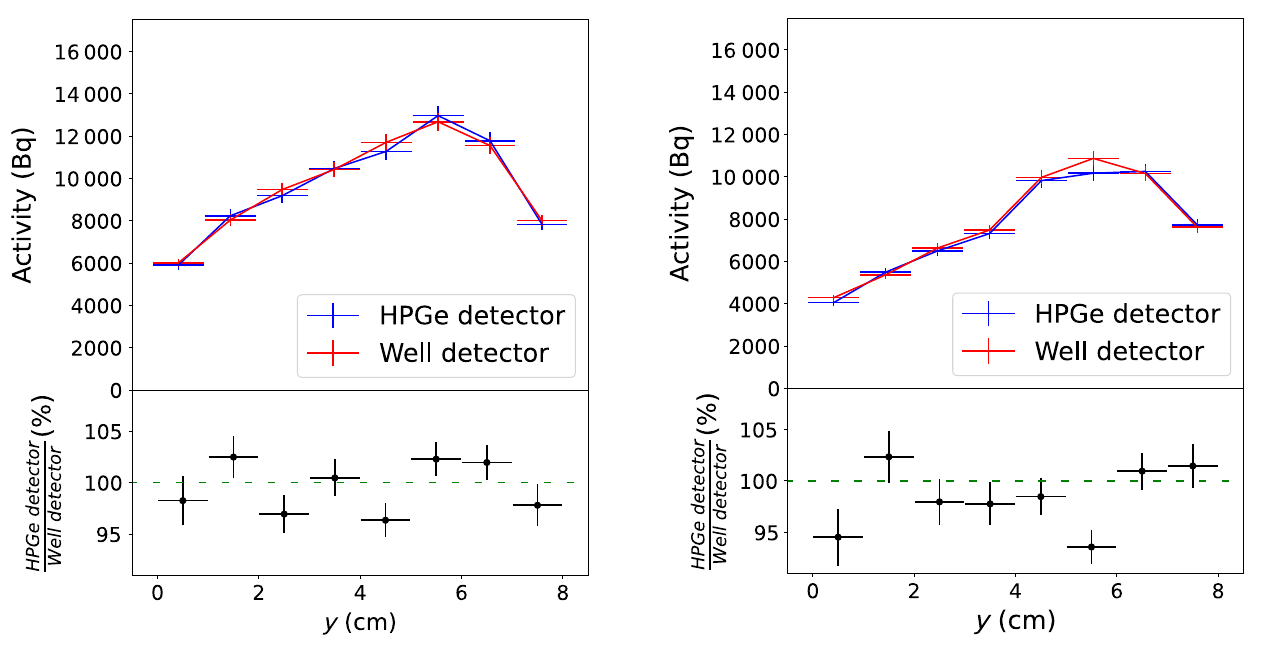
FIG. 10. Comparison of Rod 3b activity measurements using an HPGe and a well-type detector. Refer to the caption of Fig. 9 for details related to the plotting.